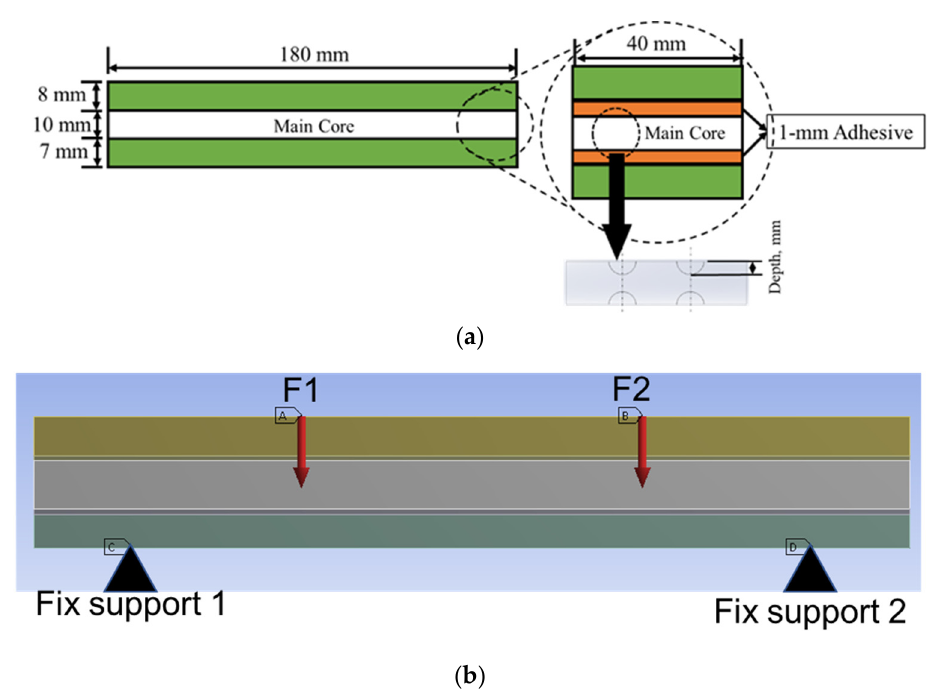
Figure 2. The sketch and setup of a geometrical panel ( a ) with its dimensions and ( b ) in the four- point bending simulation. Table 1. The nine main failure criteria, segregated from the simulation